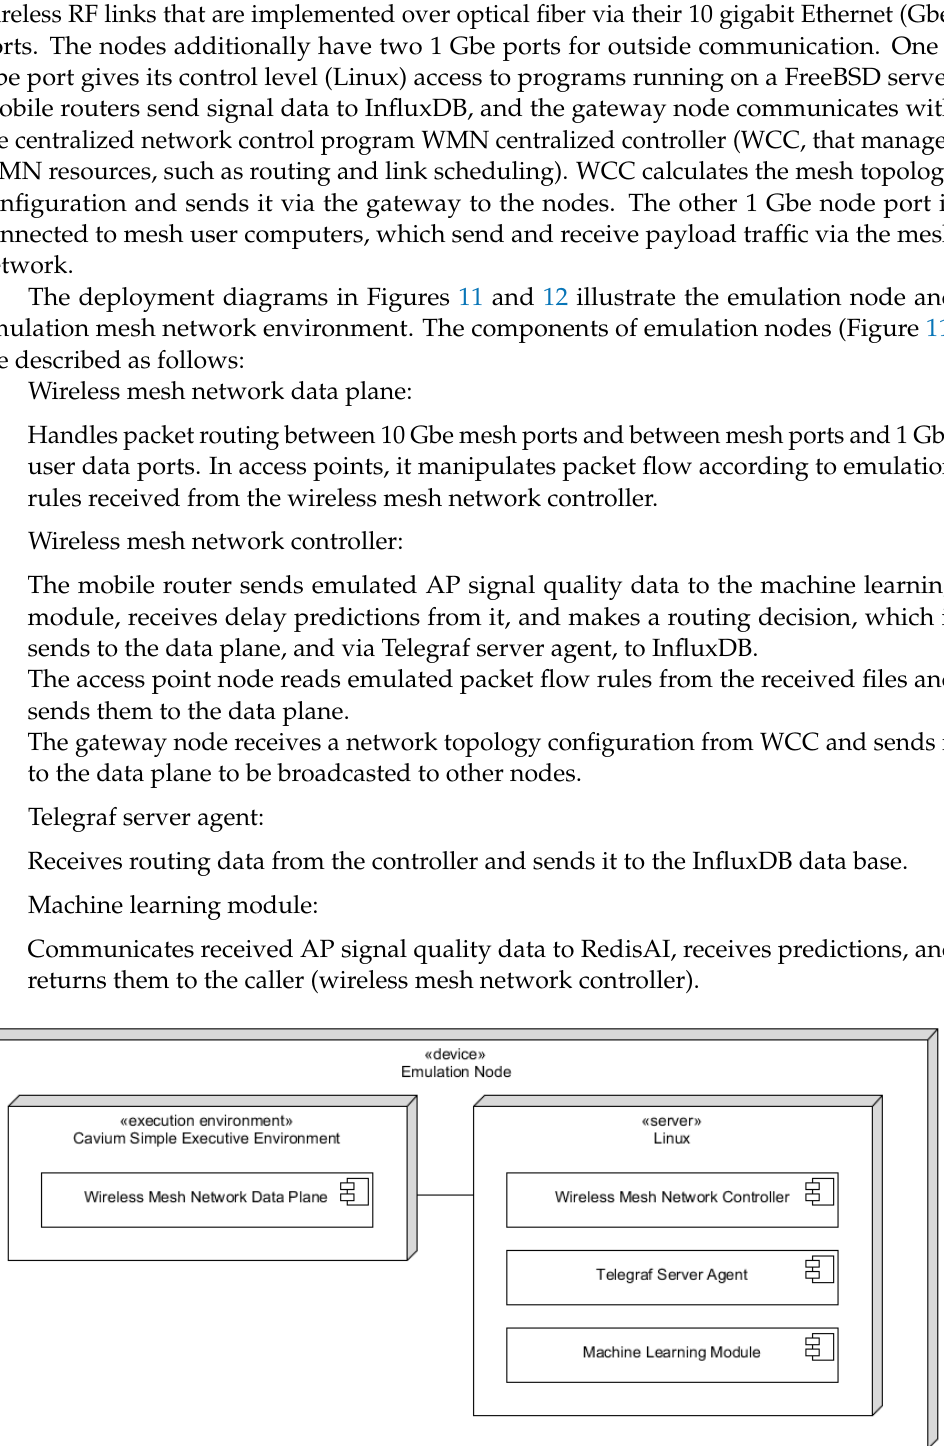
Figure 11. Deployment diagram of an emulation node.